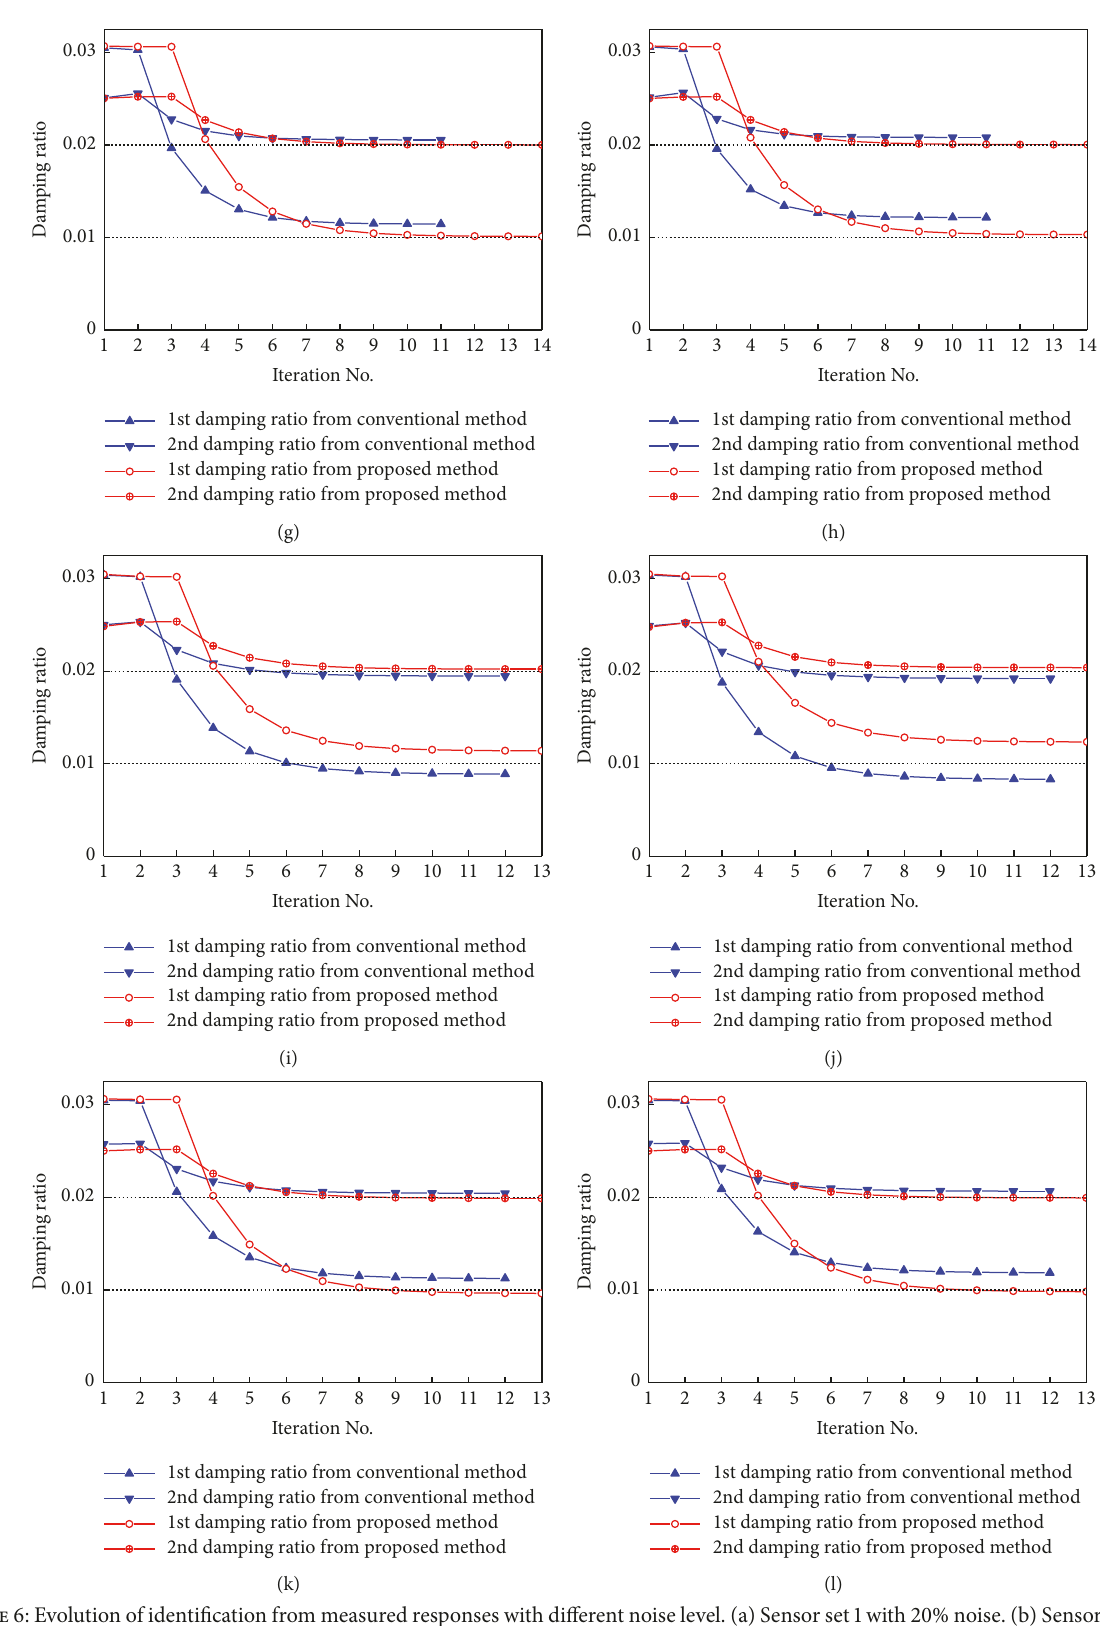
Figure 6: Evolution of identification from measured responses with different noise level. (a) Sensor set 1 with 20% noise. (b) Sensor set 1 with 30% noise. (c) Sensor set 2 with 20% noise. (d) Sensor set 2 with 30% noise. (e) Sensor set 3 with 20% noise. (f) Sensor set 3 with 30% noise. (g) Sensor set 4 with 20% noise. (h) Sensor set 4 with 30% noise. (i) Sensor set 5 with 20% noise. (j) Sensor set 5 with 30% noise. (k) Sensor set 6 with 20% noise. (l) Sensor set 6 with 30%